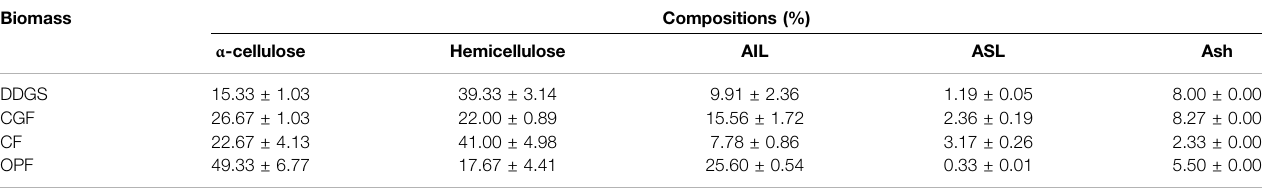
TABLE 1 | Composition of untreated lignocellulosic biomass used in the study. Biomass